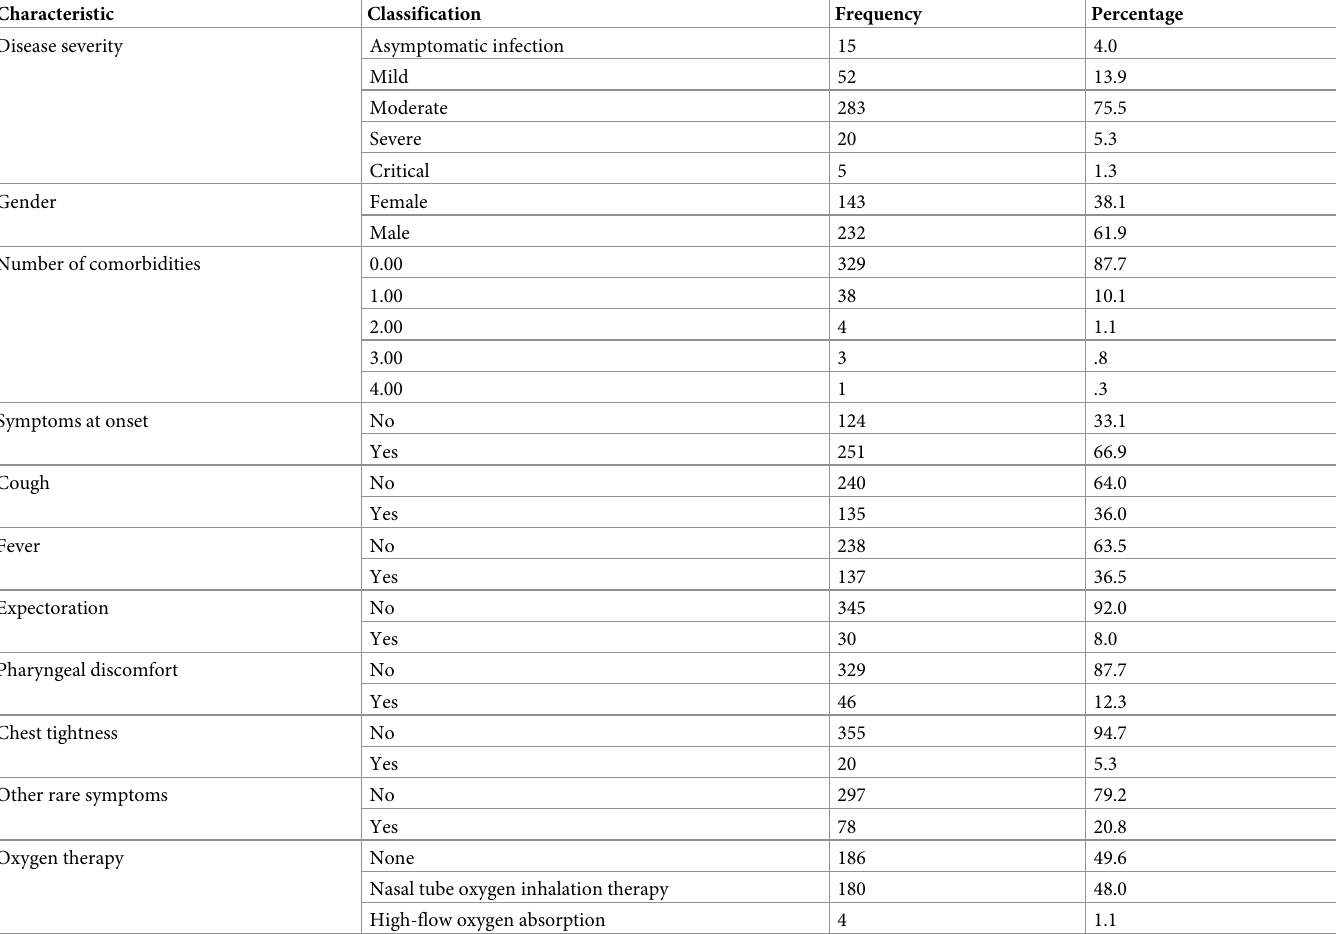
Table 1. Patients’ demographic and clinical